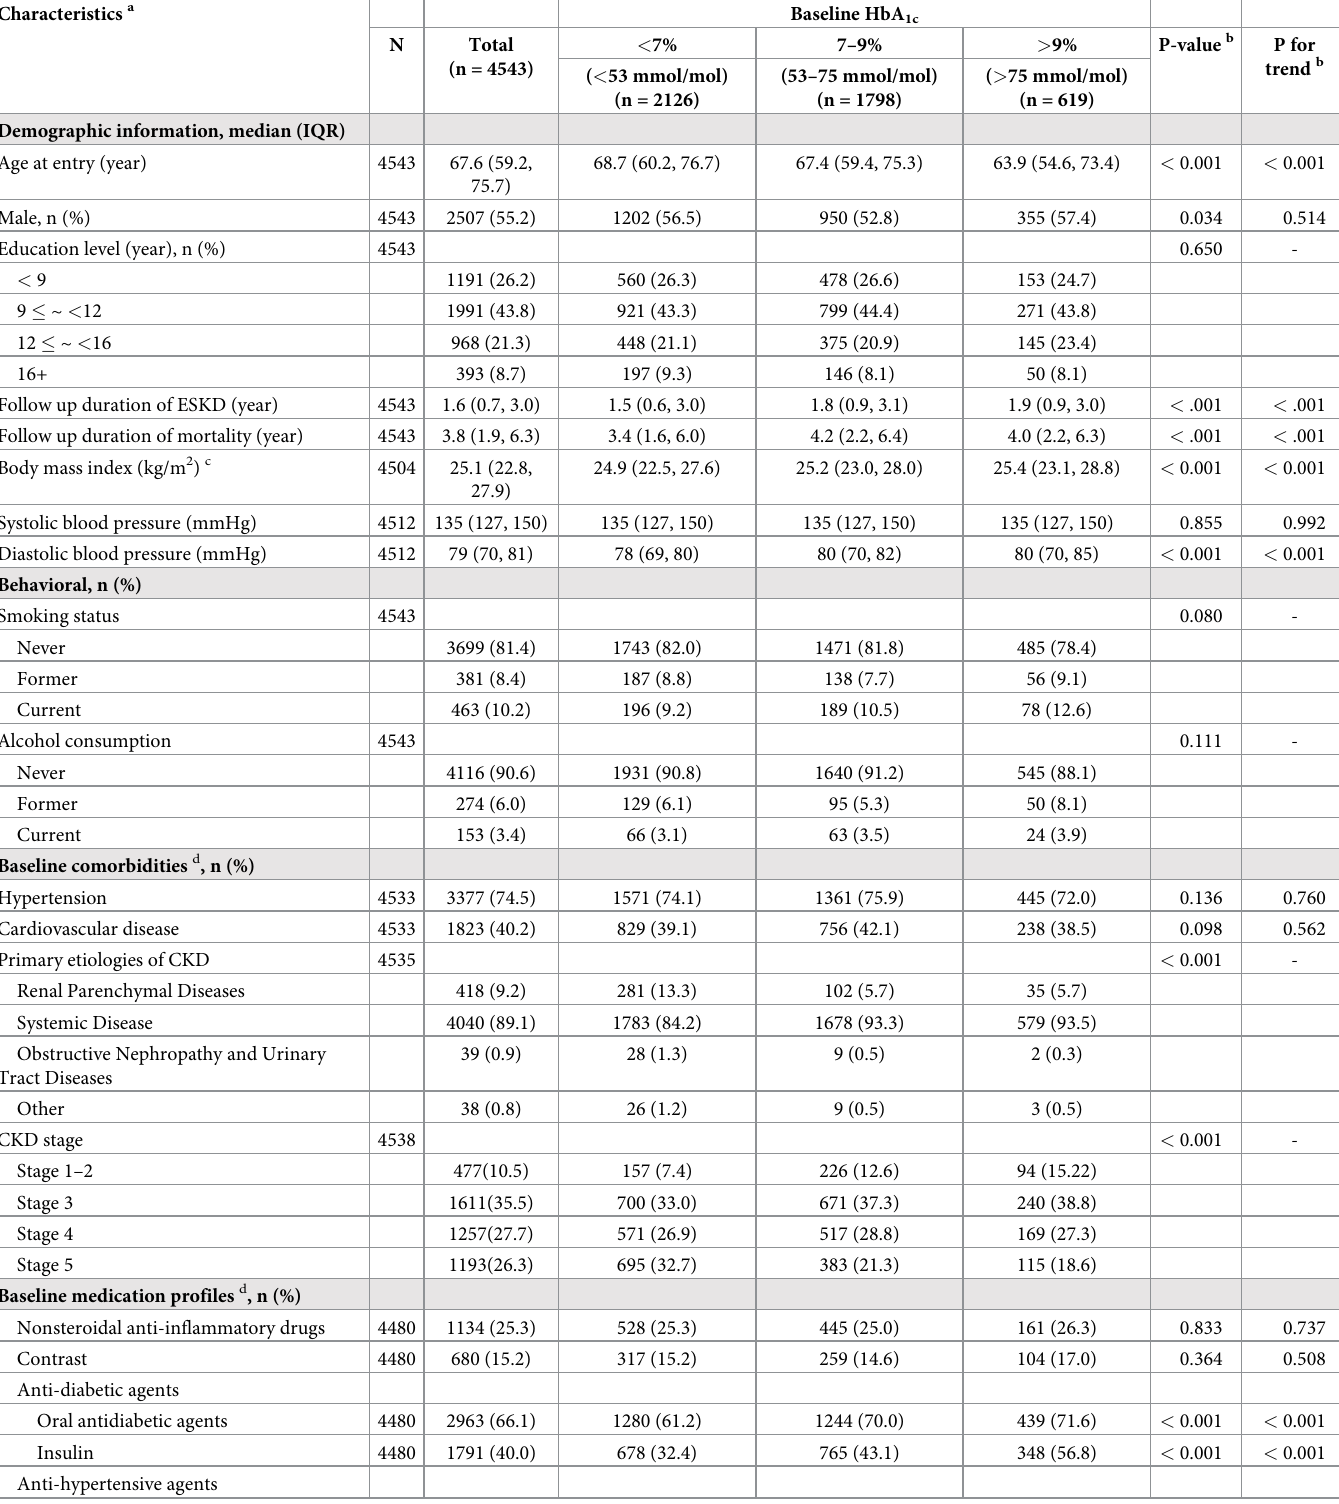
Table 1. Demographic and clinical characteristics of the study population by baseline HbA 1c categories. Characteristics